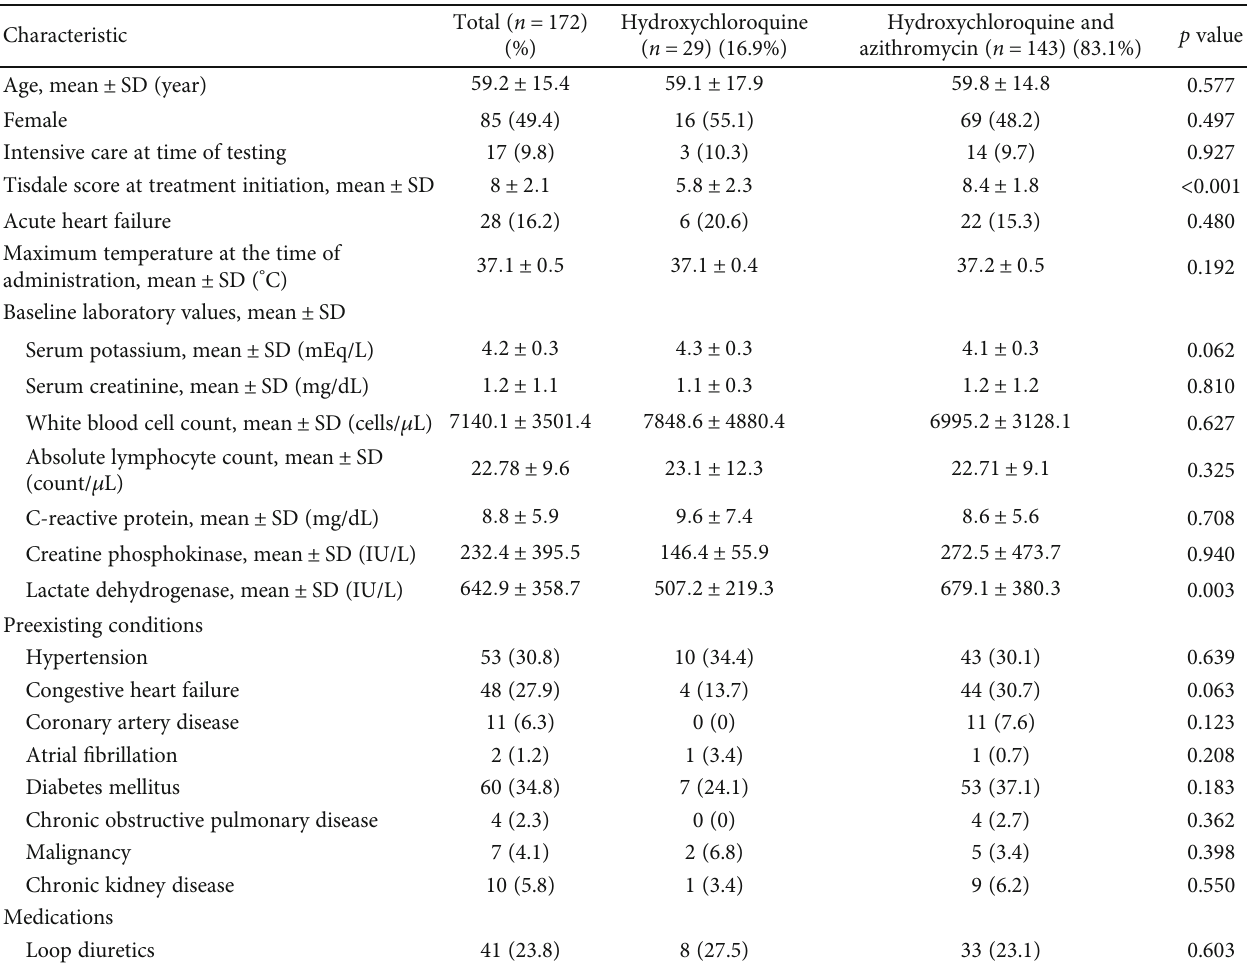
Table 1: COVID-19 patients ’ characteristics at the time of administration.